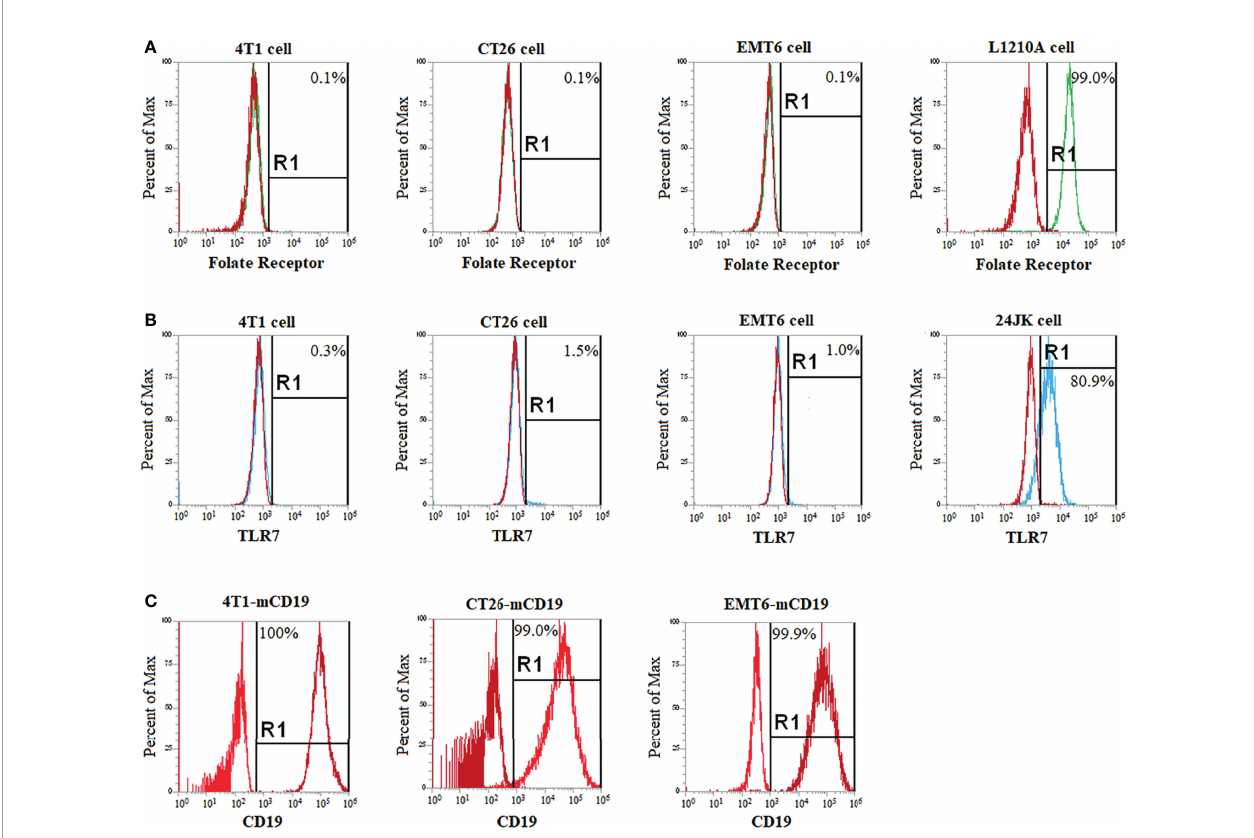
FIGURE 1 | Selection of a CD19 + cancer cell line that expresses no folate nor TLR7 receptor and will grow in immune competent mice. Cancer cells lines (4T1, CT26, EMT6) that were known to grow in immune competent mice were cultured for 1 week in folate de fi cient medium to upregulate inducible folate receptors (if any) and then screened by fl ow cytometry to assure that the cells still expressed neither a folate receptor (A) nor a Toll-like receptor 7 (B) . Known folate receptor positive (L1210A cells) and TLR7 positive (24JK cells) were used as positive controls. FR and TLR7 negative cell lines were then stably transduced with murine CD19 (mCD19) to create a cancer cell line that would respond to an anti-CD19 CAR T cell therapy. Successful expression of CD19 was con fi rmed after one-month of culturing by fl ow cytometry (C) . Each fl ow cytometry analysis was performed at least three times, with representative histograms shown